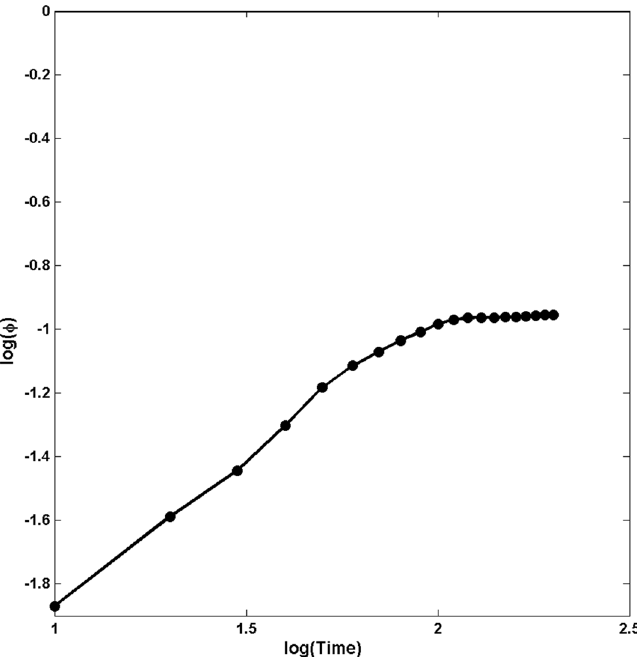
Figure 2. The dynamic growth of the normalized thickness φ of the amorphous region in Structure C. The slope of the straight line is α ≈ 0.9 .